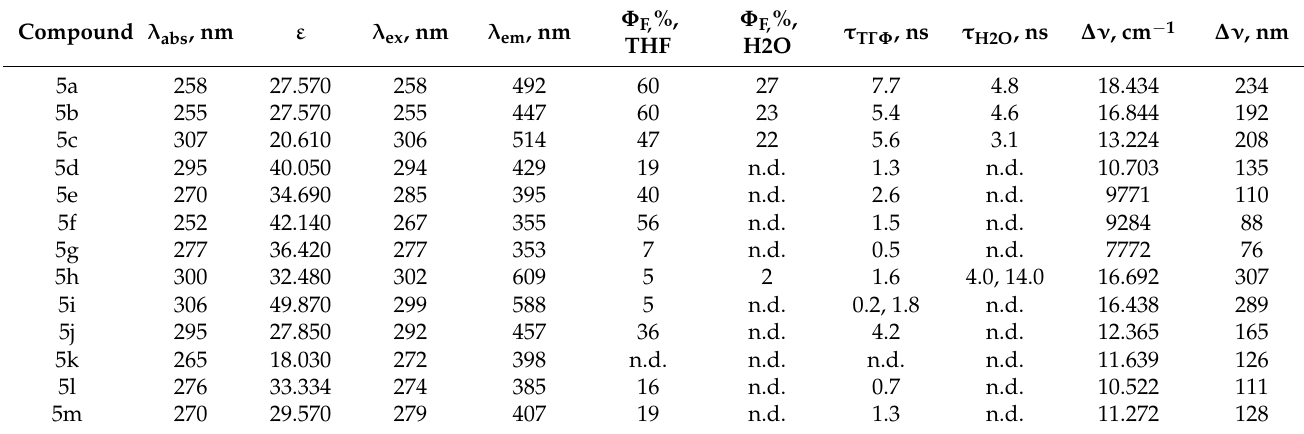
Table 1. Photophysical parameters of triazoles 5a – m